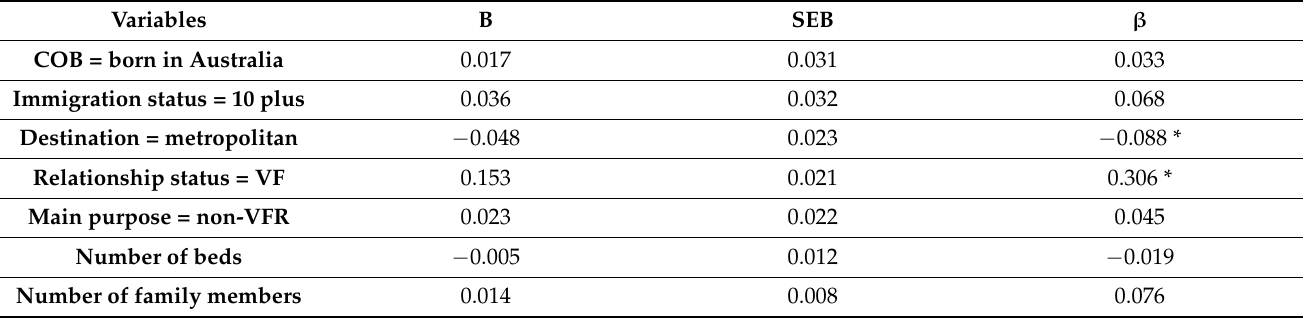
Table 5. Regression analysis summary of the host’s variables predicting the duration of stay of travel parties.